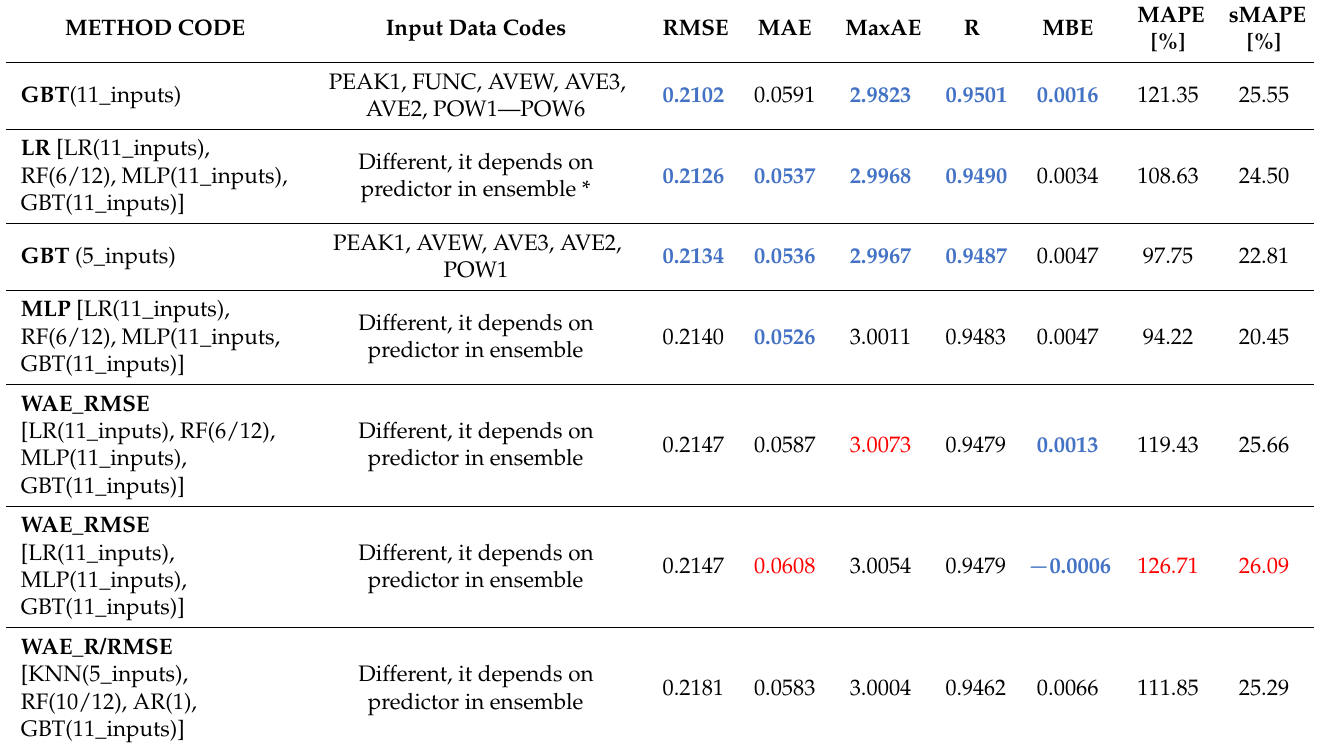
Table 7. Performance measures of proposed ensemble methods (on test subset) for time series No. 1. METHOD